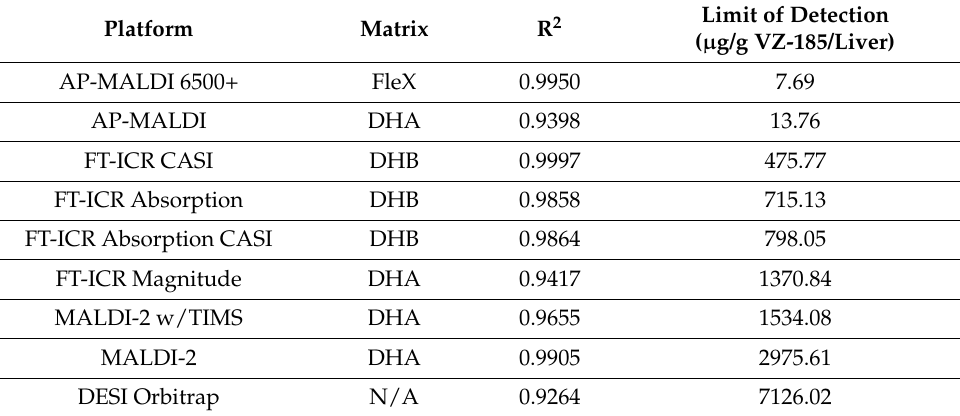
Table 3. Comparison of lowest limit of detection across the imaging platforms, adjusted to 20 µ m 2 pixels. While 3 matrices were used in the initial experiment, FleX did not provide the lowest LoD for VZ-185. Except for the CASI and absorption mode FT spectra, all reported lowest LoD with DHA. Despite this, the AP-MALDI-6500+ platform exceeded all other platforms by ~2-fold while only being run with FleX matrix. R 2 values of the linear regression are generally poorer than for felodipine, but all are above